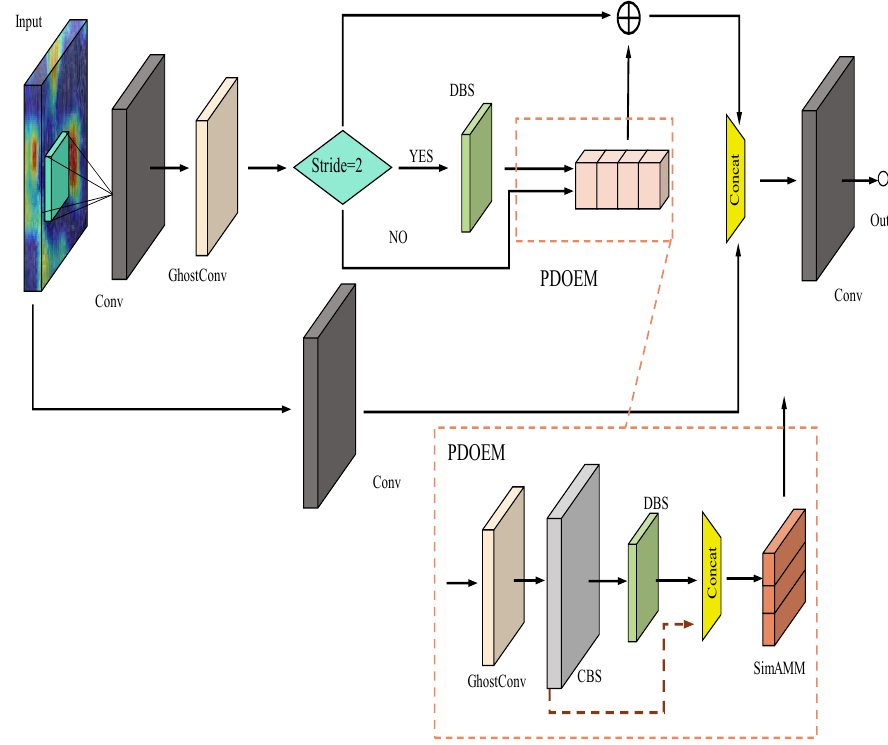
Figure 4. Structure design of the PDOEM feature information extraction module.